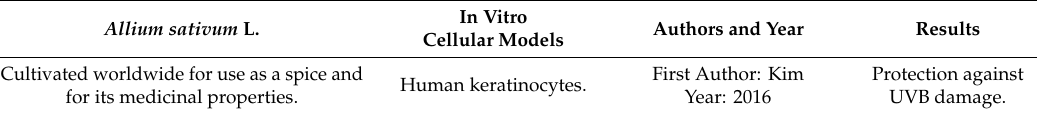
Table 3. Schematic representation of in vitro cellular models used to test the role of Allium sativum L. In Vitro Allium sativum L. Cellular